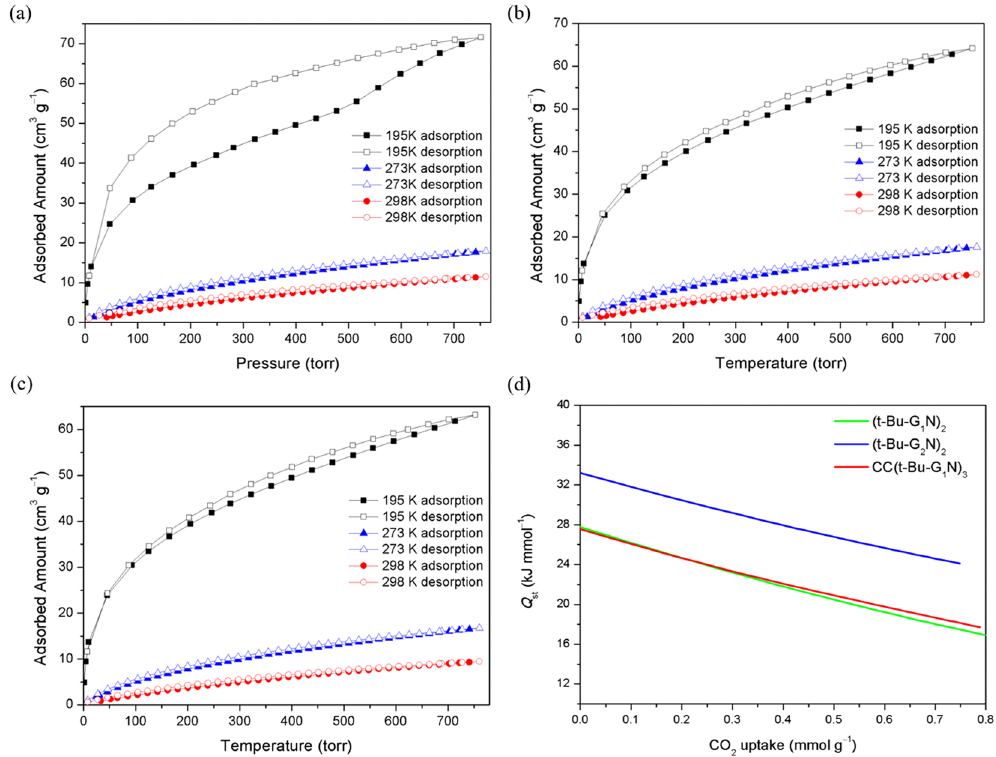
Figure 4. ( a ) CO 2 sorption isotherms for ( t - Bu - G 1 N ) 2 measured at 195 K, 273 K and 298 K. ( b ) CO 2 sorption isotherms for CC ( t - Bu - G 1 N ) 3 measured at 195 K, 273 K and 298 K. ( c ) CO 2 sorption isotherms for ( t - Bu - G 2 N ) 2 measured at 195 K, 273 K and 298 K. ( d ) Isosteric heat ( Q st ) of CO 2 sorption for ( t - Bu - G 2 N ) 2 , CC ( t - Bu - G 1 N ) 3 and ( t - Bu - G 1 N ) 2 (only sorption data at 273 K and 298 K were